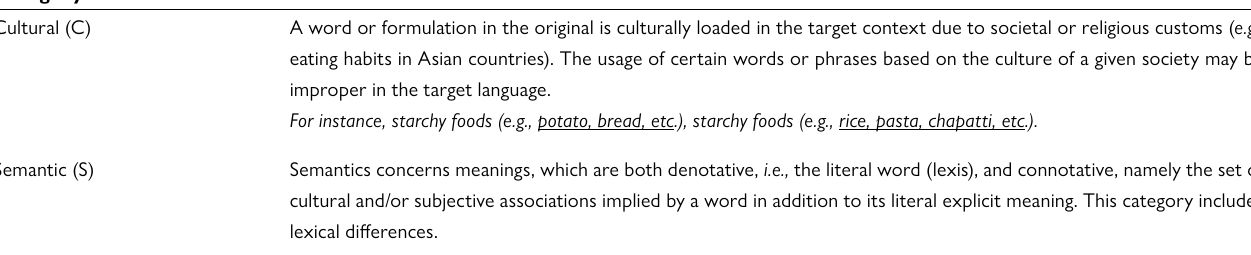
Table 1. Categorization of translation difficulties Category Definition